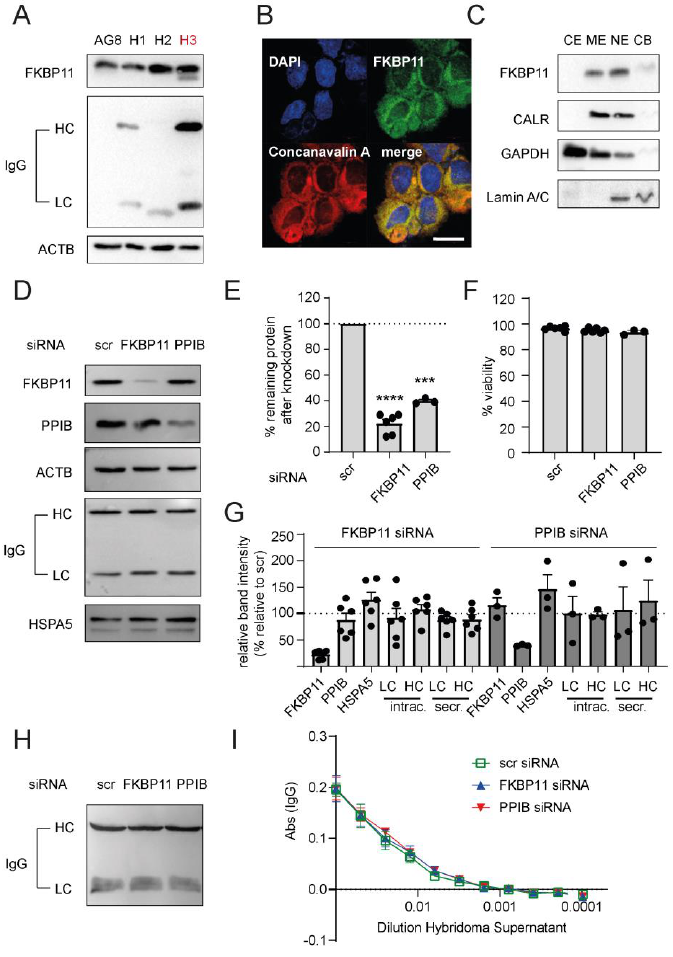
Figure 6. Knockdown of FKBP11 or PPIB does not reduce antibody yield of a hybridoma cell line. ( A ) Protein levels of FKBP11 and rat IgG in three different rat/mouse hybridoma cell lines (H1 – H3) and the mouse myeloma cell line P3X63-Ag8.653 (AG8) used for fusion. H3 was chosen for subse- quent experiments. ( B ) Confocal microscopy demonstrated colocalization of FKBP11 with the ER marker concanavalin A. Scale bar 20 µm. ( C ) Subcellular fractionation showed a similar enrichment pattern for FKBP11 as for the ER-resident protein calreticulin (CALR), with main localization in the microsomal (ME) and the nuclear extract (NE), but little to no detection in the cytosolic extract (CE) and the chromatin-bound fraction (CB). ( D ) Representative Western Blot analysis showing levels of FKBP11, the known antibody folding catalyst PPIB, loading control β -actin (ACTB), intracellular IgG antibody heavy (HC) and light chain (LC), and ER chaperone HSPA5, following siRNA-mediated knockdown of FKBP11 or PPIB in hybridoma cell line H3. ( E ) Mean FKBP11 knockdown efficiency in the rat hybridoma cell line H3 was 78 ± 3% ( n = 6; paired t -test; **** p < 0.0001), mean PPIB knockdown efficiency in the same cell line was 60 ± 1% ( n = 3; paired t -test; *** p < 0.001). ( F ) Knock- down of FKBP11 ( n = 6) or PPIB ( n = 3) did not affect cell viability relative to scr siRNA control. ( G ) Quantification of immunoblot band intensities (see representative immunoblots for intracellular protein in panel D , for secreted IgG in panel H ) following FKBP11 or PPIB knockdown revealed no significant changes except for the siRNA targets FKBP11 and PPIB; data for the latter two is identical to panel E; intrac., intracellular; secr., secreted. ( H ) Representative Western Blot analysis showing levels of secreted IgG antibody heavy (HC) and light chain (LC), following siRNA-mediated knockdown of FKBP11 or PPIB in hybridoma cell line H3. Quantification is given in panel G (secr. IgG, LC, HC). ( I ) ELISA-based IgG quantification showed no significant effect on antibody secretion from FKBP11-, PPIB- or scr siRNA-transfected H3 cells ( n =